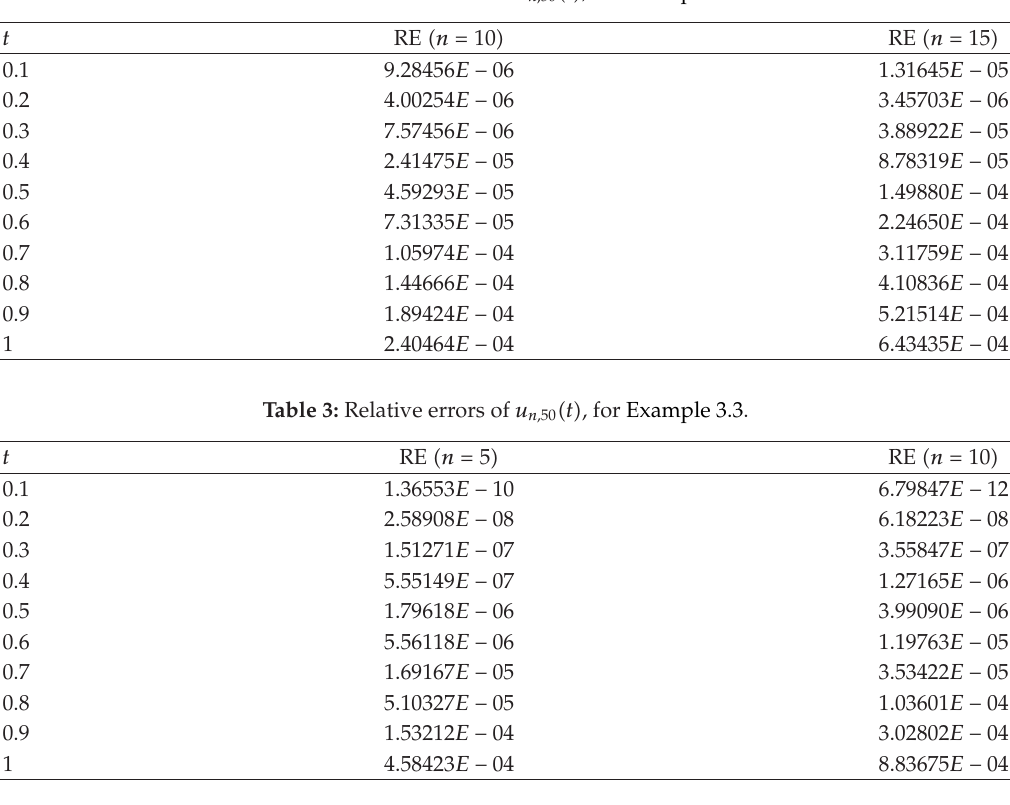
Table 2: Relative errors of u n,